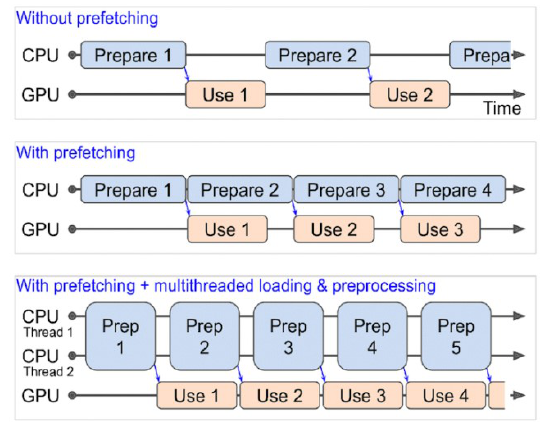
Fig. 2. Prefetch Dataset